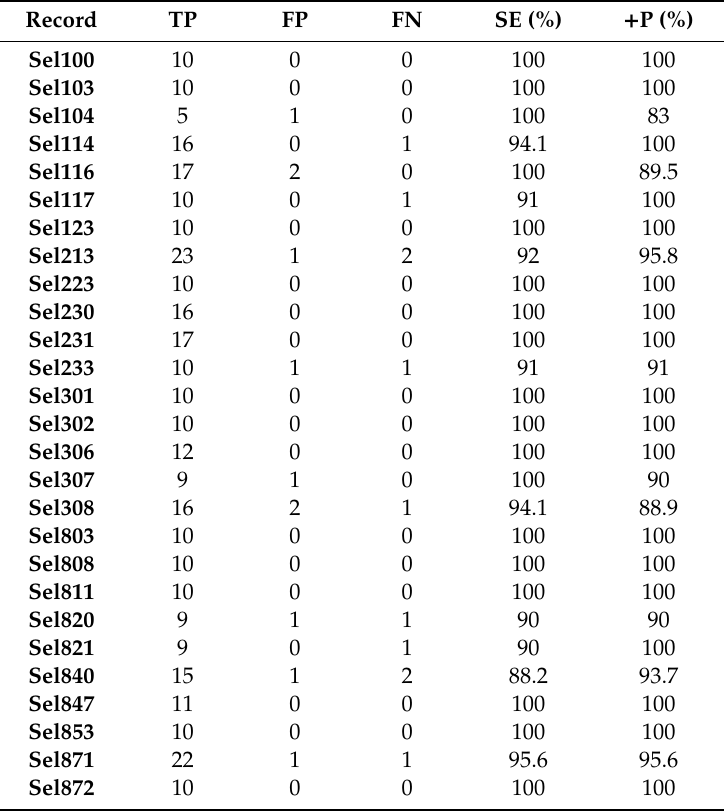
Table 5. P-wave detection performance over the manual annotated QT